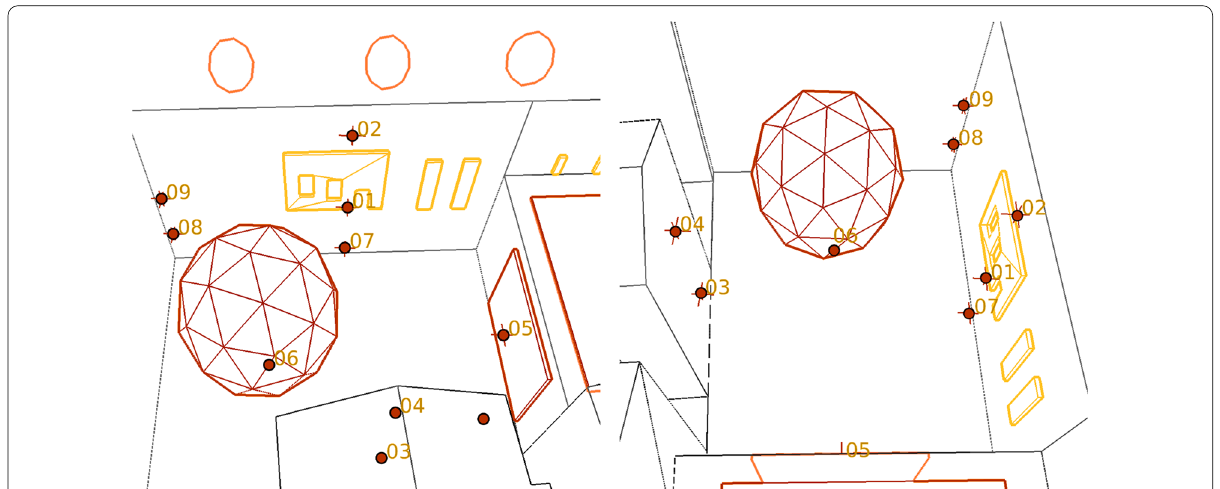
Fig. 10 Selected positions for the evaluation of the simulated temperature profiles within the transient simulation with uhiSolver